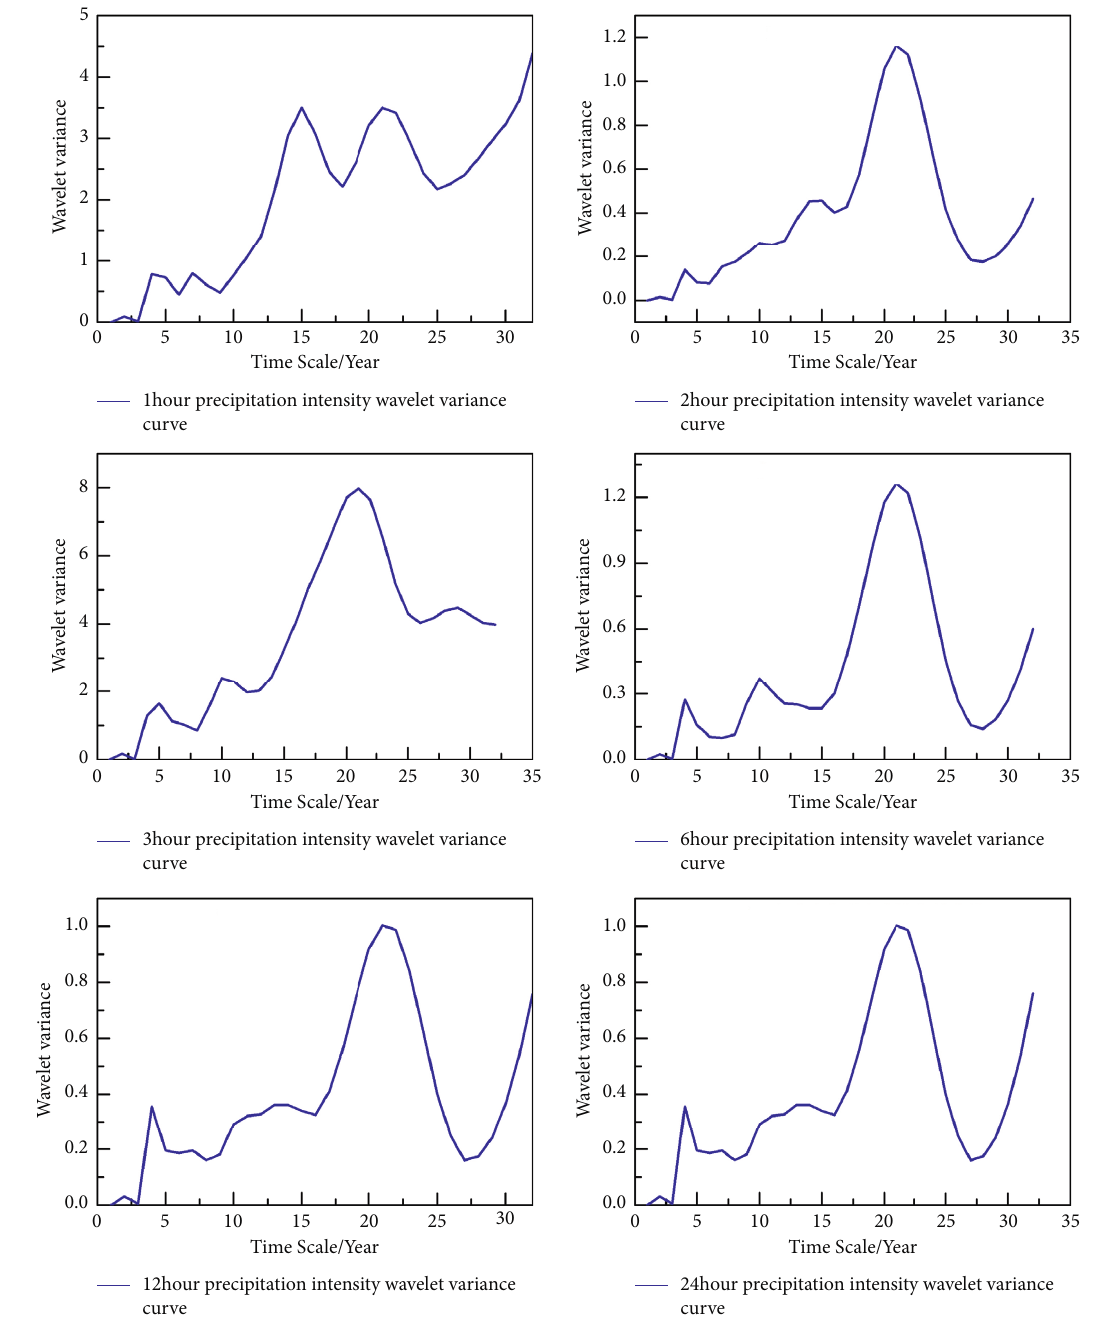
Figure 10: Plots of the wavelet variances of the intensities of precipitation with different durations in the study area from 1959 to